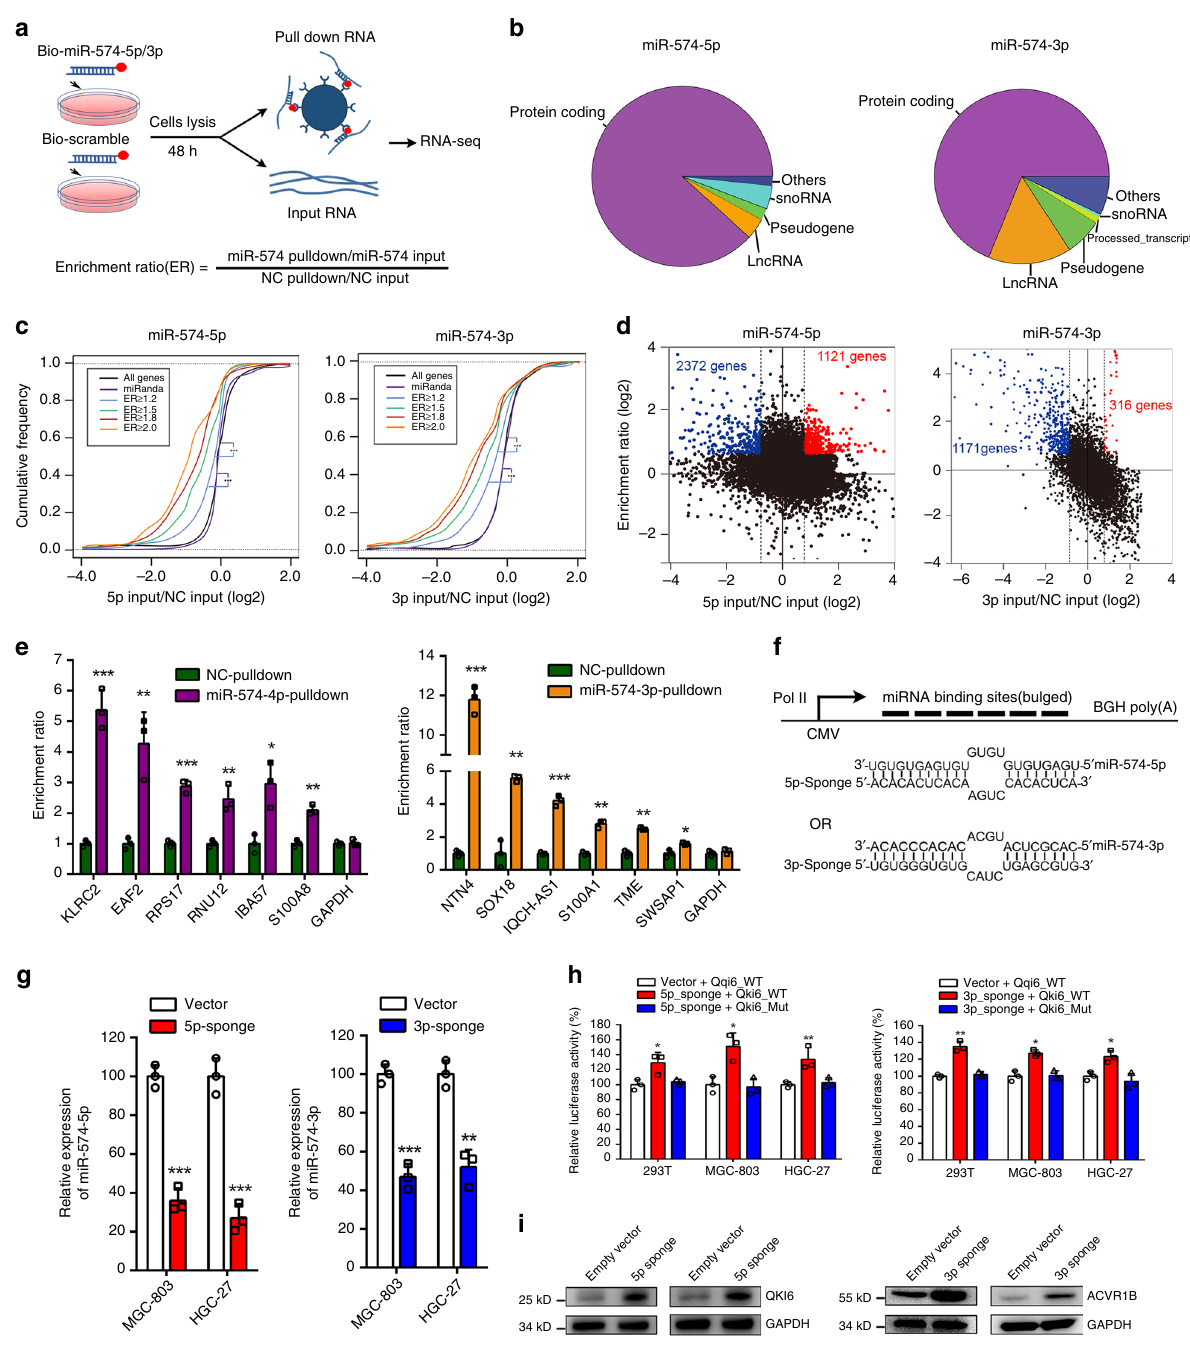
Fig. 4 Systematic identi fi cation of miR-574-5p/-3p targets in GC cells. a Schematic representation of biotinylated miRNA pull-down experiment. b Classi fi cation of miR-574-5p/-3p enriched targets. c , d The expression change of miR-574-5p/-3p pulled down targets versus all genes or miR-574-5p/-3p targets predicted by miRanda in miR-574-5p/-3p overexpressed cells. ER: enrichment ratio. e qRT-PCR validation of the enrichment of the potential targets in miRNA pulled down experiment. f Schematic representation of arti fi cial miR-574-5p/-3p sponges expressing RNAs with six binding sites (6× target) that pair extensively with the seed and 3 ′ -end of the miRNAs but contain a central bulge. g Relative expression of miR-574-5p/-3p in GC cells with overexpression of arti fi cial miR-574-5p/-3p sponges. h Relative luciferase activity of wild type QKI6 or ACVR1B 3 ′ UTRs constructs in 293T and GC cells simultaneously treated with arti fi cial miR-574-5p/-3p sponges. i The protein level of QKI6 or ACVR1B in GC cells with overexpression of arti fi cial miR-574-5p/-3p sponges. Three technical replicates from a single experiment representative of two independent experiments. Data are shown as means ±s.d. ** p < 0.01, *** p <0.001, Student ’ s t